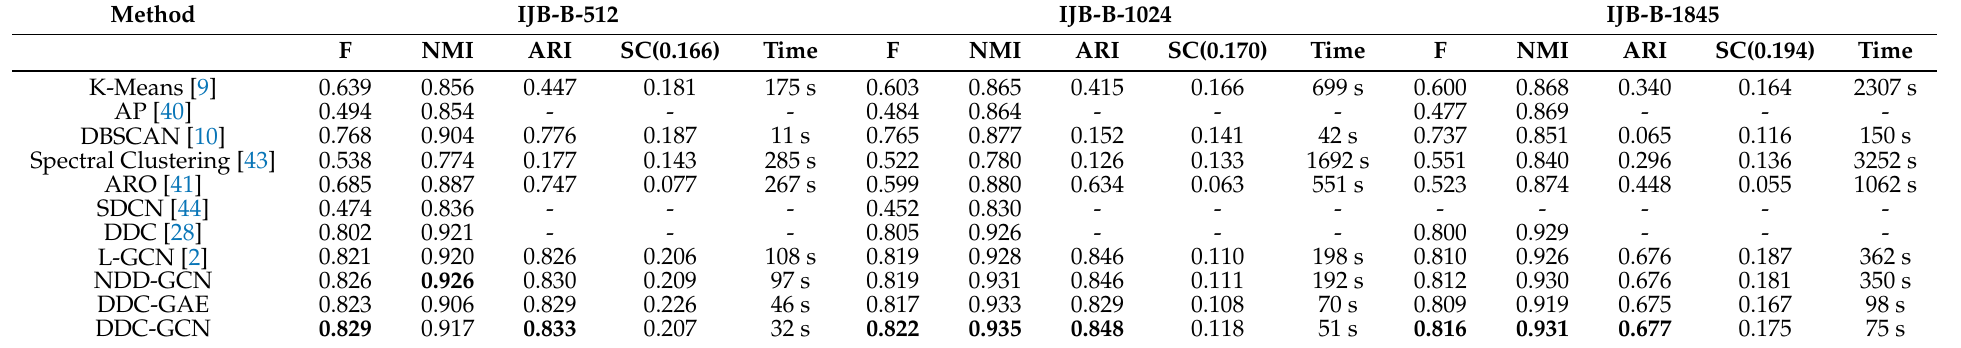
Table 4. Comparison on IJB-B